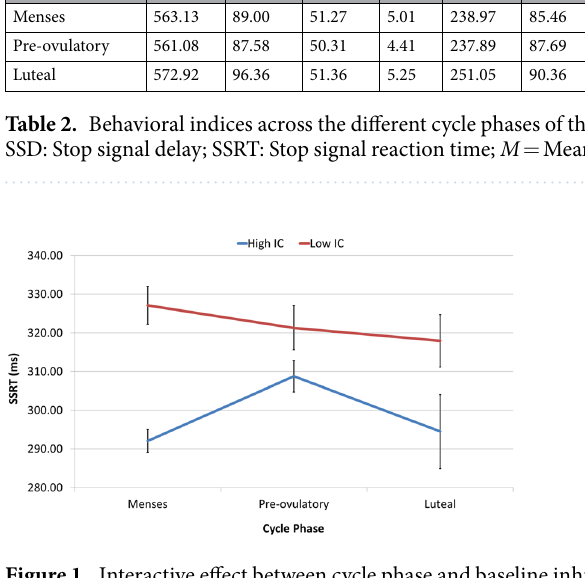
Figure 1. Interactive effect between cycle phase and baseline inhibitory control (IC) on the Stop signal reaction time (SSRT): Women that are faster during their menses, become slower during their pre-ovulatory phase, while women that are slower during their menses, become faster during their pre-ovulatory phase. Baseline IC as a covariate of interest was used as a continuous variable, but the sample is split by the median for displaying purposes. Error bars represent standard errors.